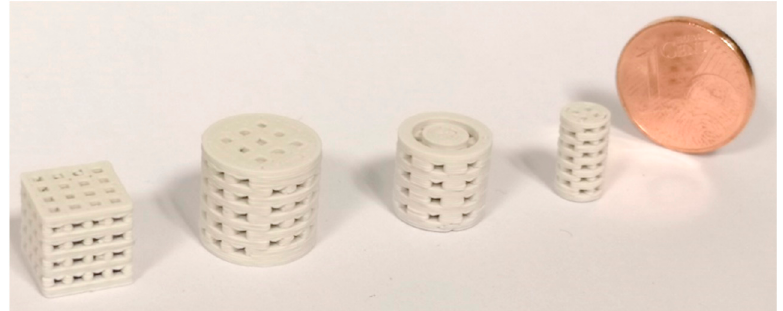
Figure 3. 3D printed scaffolds, the nozzle diameter was 0.5 mm, layer height was 0.1 mm.